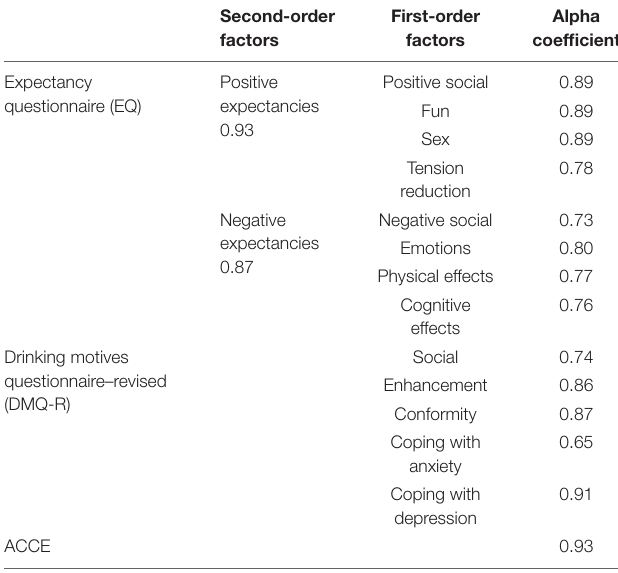
TABLE 1 | Reliability coefficients of the evaluated